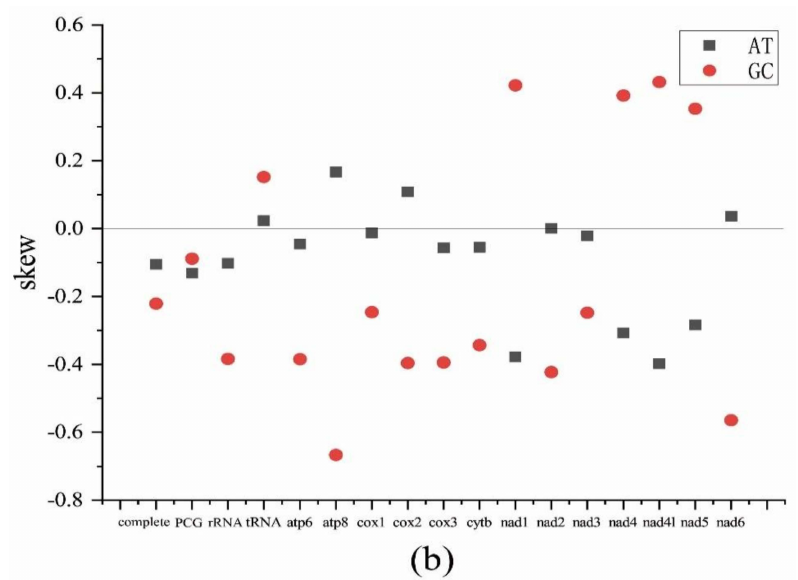
Figure 2. The nucleotide composition and skew of the S. jimo mitogenome. ( a ) Nucleotide composition (A/T/G/C percentage) of the mitogenome (indicated as complete) as well as ribosomal RNA (rRNA), transfer RNA (tRNA), and protein-coding genes. ( b ) AT-skew and GC-skew across the mitogenome (indicated as complete) and rRNA, tRNA, and protein-coding genes.